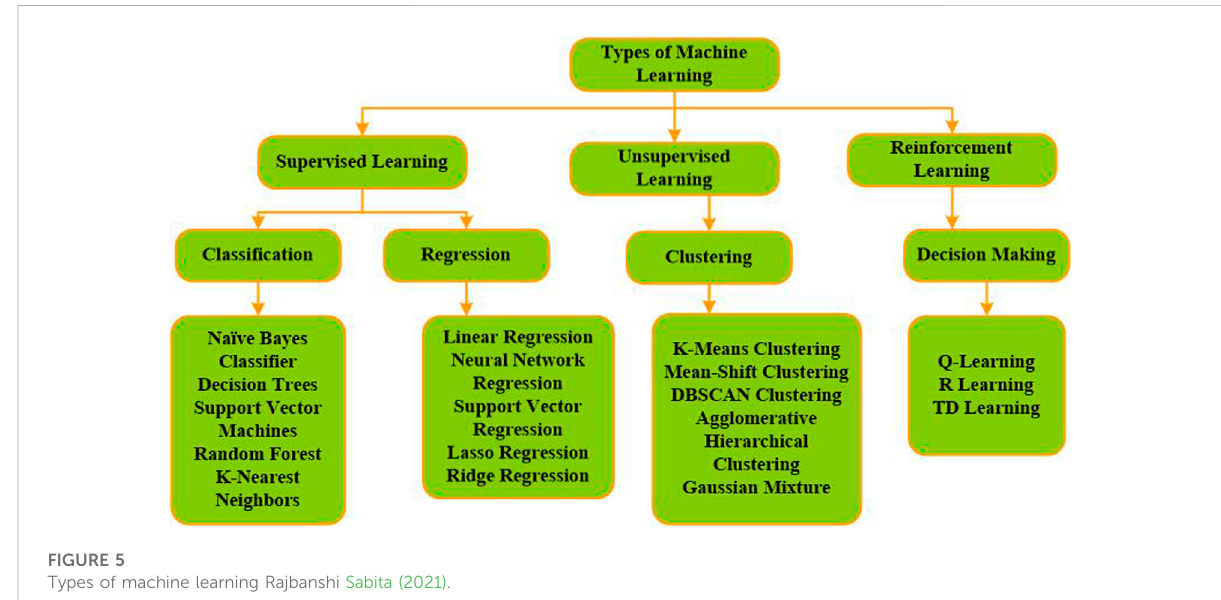
FIGURE 5 Types of machine learning Rajbanshi Sabita (2021).